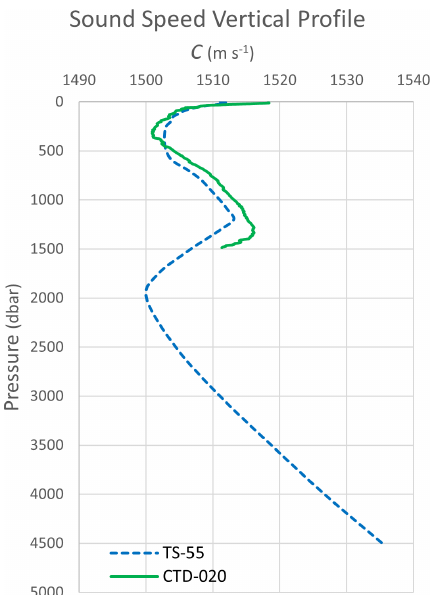
Figure 4. Comparison between in situ and Conservative Tempera- ture of the TEOS-10 Test Data included in TEOS-10 Excel. This plot is one of six included in the Vertical Profiles